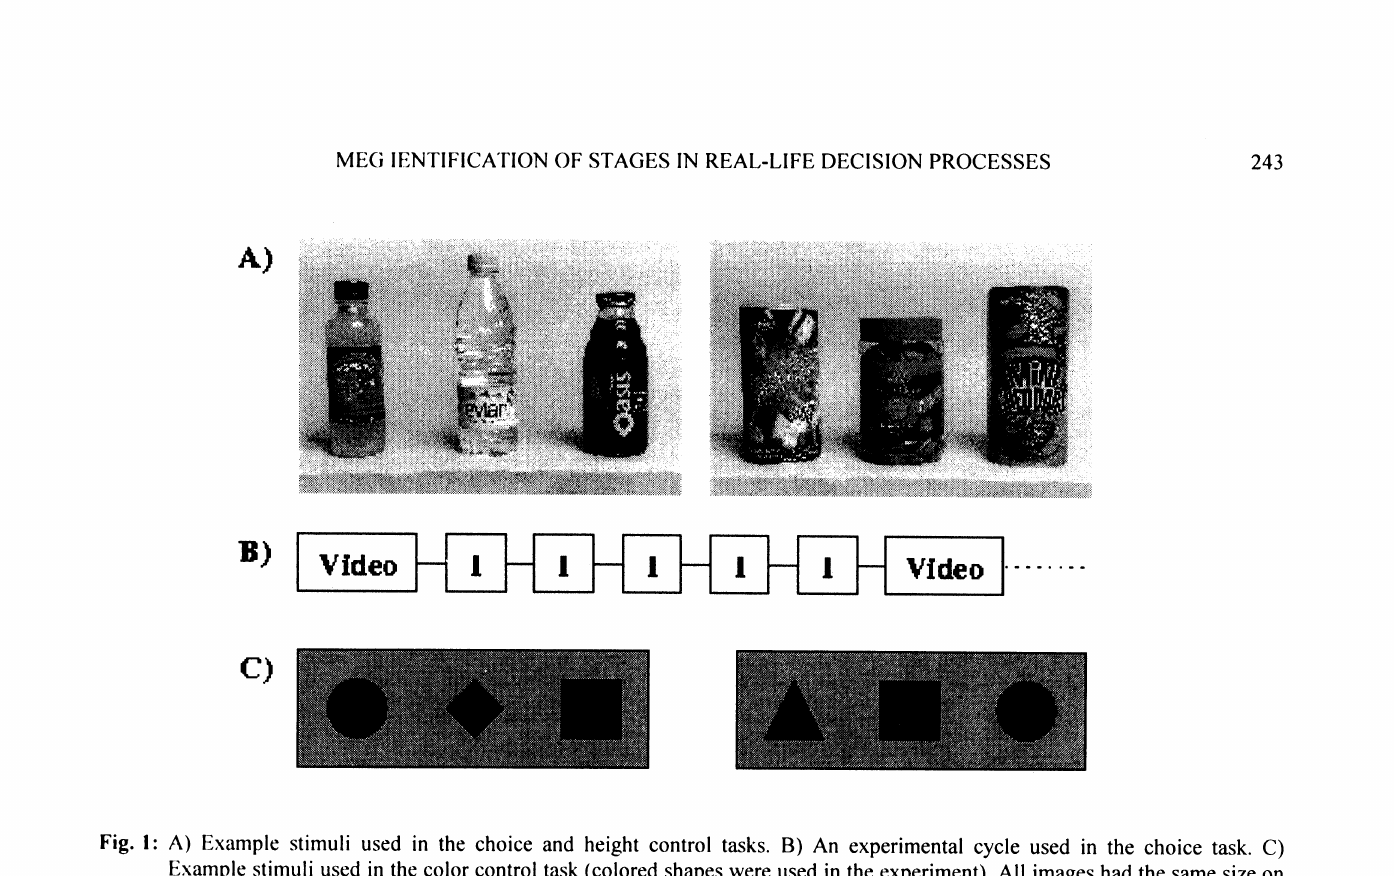
Fig. I: A) Example stimuli used in the choice and height control tasks. B) An experimental cycle used in the choice task. C) Example stimuli used in the color control task (colored shapes were used in the experiment). All images had the same size on